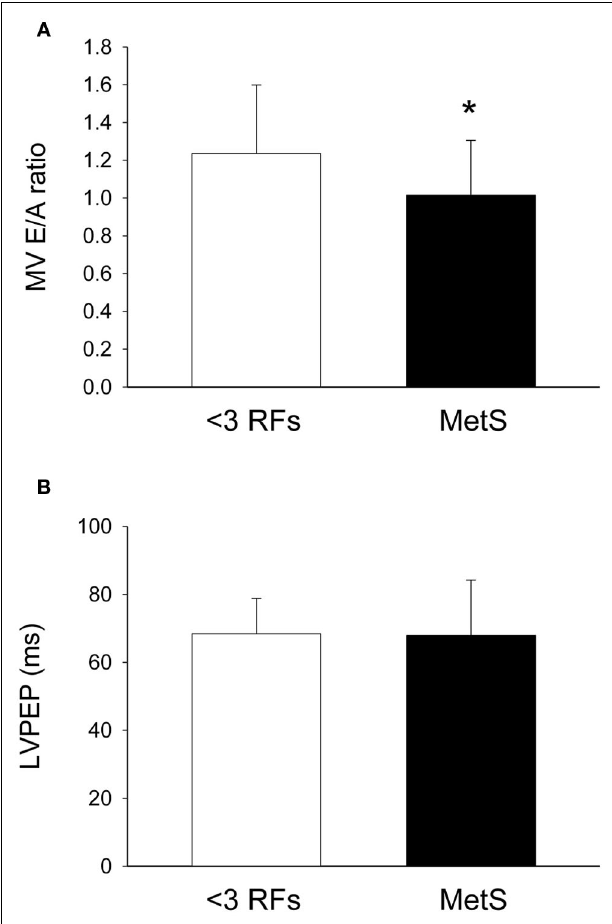
FIGURE 2 | Echocardiography of individuals with metabolic syndrome (MetS). After adjustment for statin and blood pressure medication use, compared with individuals with less than three risk factors for cardiovscular disease ( < 3 RFs) participants with MetS displayed (A) lower mitral valve E / A ratio (MV E / A ratio; an indicator of left ventricle relaxation; P = 0.03) and (B) no difference in left ventricular pre-ejection period (LVPEP; P = 0.27). There were significant effects of anti-hypertension medication use on LVPEP (see Table 4 ).Values are mean ± SD. Corresponding SE values are (A) 0.07 ( < 3 RFs) and 0.04 (MetS); (B) 2.0ms ( < 3 RFs) and 2.6ms